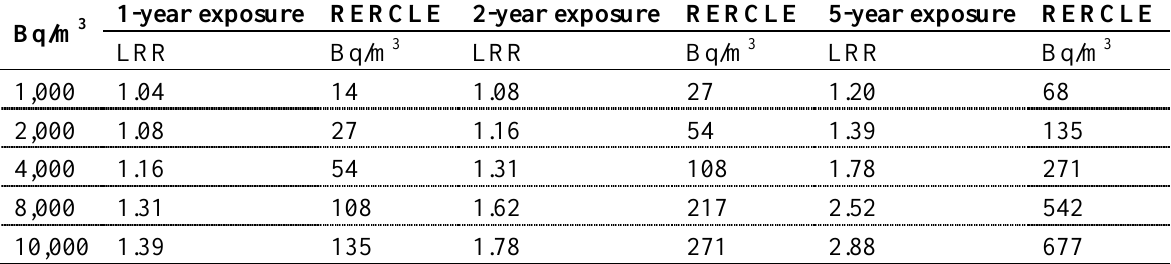
Table 2. Risk equivalent radon concentration for lifetime exposure (RERCLE) when Canadian girls are exposed to radon concentrations of 1,000, 2,000, 4,000, 8,000, and 10,000 Bq/m 3 for short periods of 1, 2 and 5